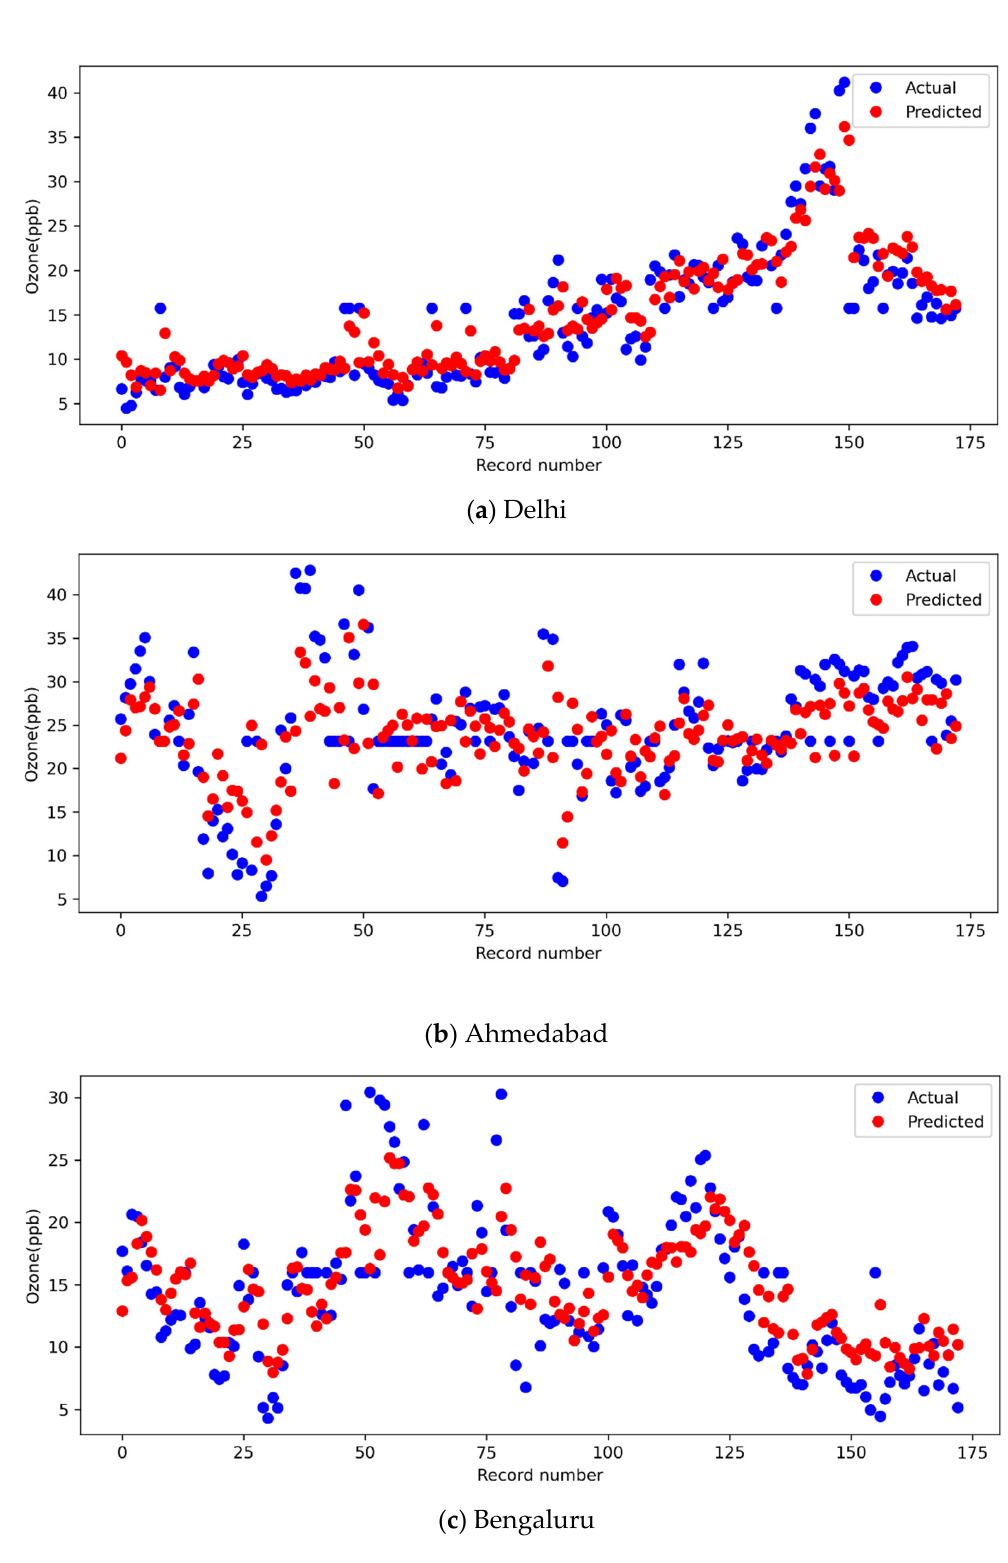
Figure 13. Predictions of O 3 concentrations using PM 2.5 during the summer season (2019 and 2020) for ( a ) Delhi, ( b ) Ahmedabad and ( c ) Bengaluru. Table 3. The performance comparison of data.